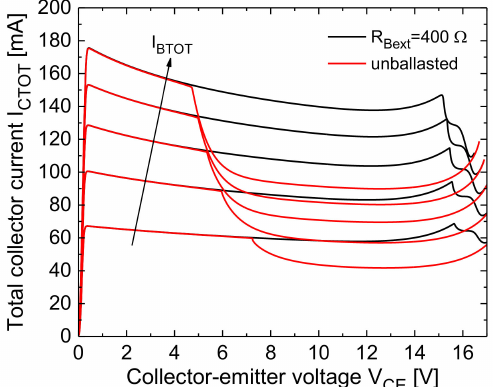
Figure 17. Simulated I CTOT – V CE characteristics for the unballasted (red) and ballasted (black) 3-cell test device for I BTOT = 0.7, 1.2, 1.7, 2.2, 2.7 mA.